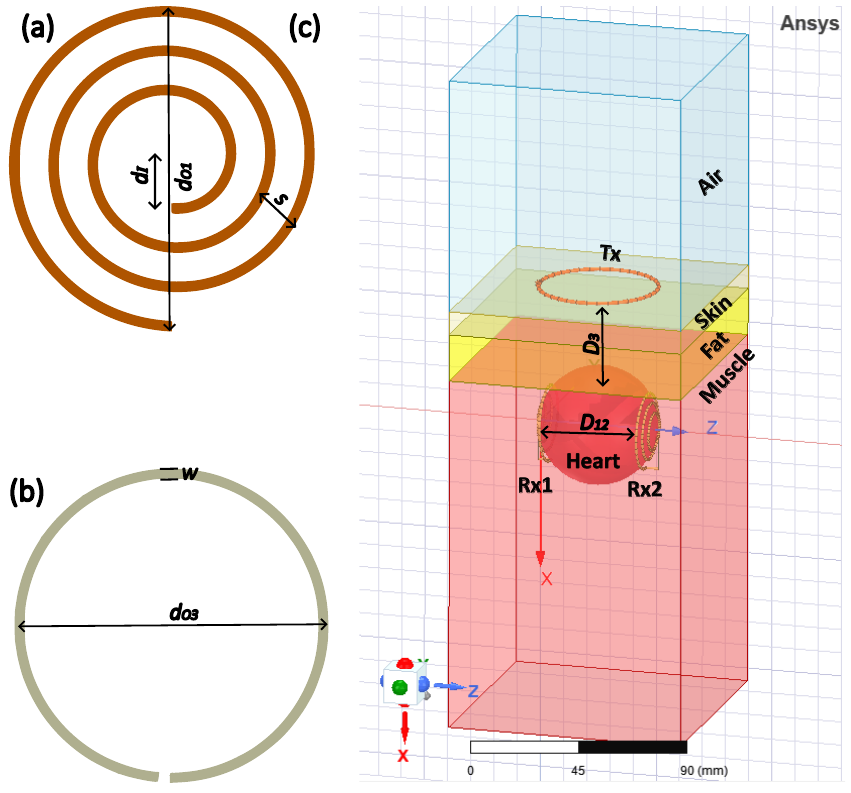
Figure 4. ( a ) Receiver Rx 1 and Rx 2 ; ( b ) transceiver Tx ; ( c ) the transceiver coil and receiver coils in the heterogeneous phantom in the simulation study. Table 1. Transceiver and receiver coil specifications at 13.56